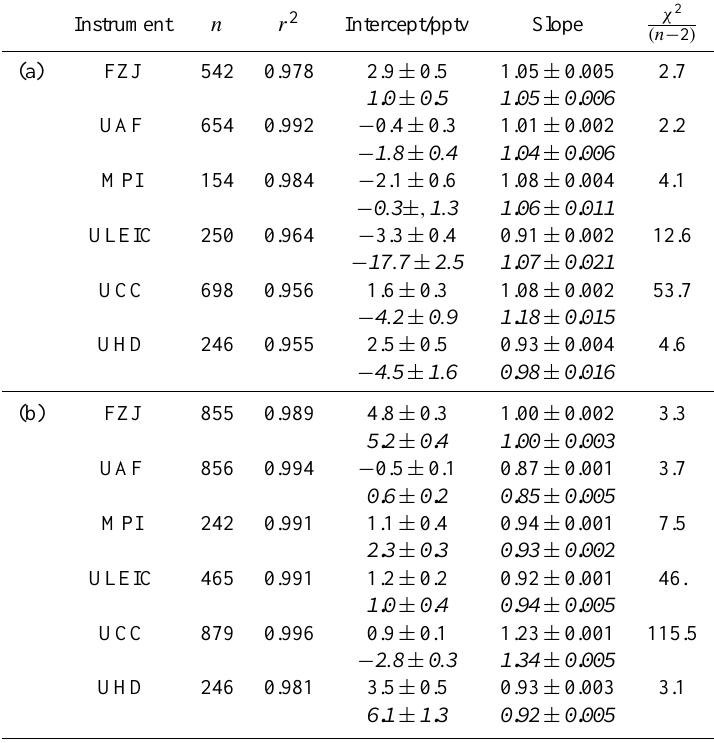
Table 3. Results of the correlation and linear regression analysis of NO 3 measurements from all instruments versus NOAA-CRDS as ref- erence on the basis of 3min averages. (a) Measurements in the absence of aerosol (cf. Fig. 5), (b) in the presence of aerosol (cf. Fig. 6). n... number of data pairs, r 2 ... Pearson linear correlation coefficient, χ 2 /(n − 2 )... reduced chi-squared. A value of ≈ 1 indicates that the scatter of the data around the regression line is well covered by the individual 1 σ measurement errors (precision) of both instruments. When the scatter of the data is larger, “fitexy” fails to calculate the correct regression parameters and their errors. The italic numbers indicate the slope and intercept for an appropriate regression model (“least normal squares”, LNS). For details see text in Sect. 3.3.2. 2 Instrument n r 2 Intercept/pptv Slope χ (n − 2